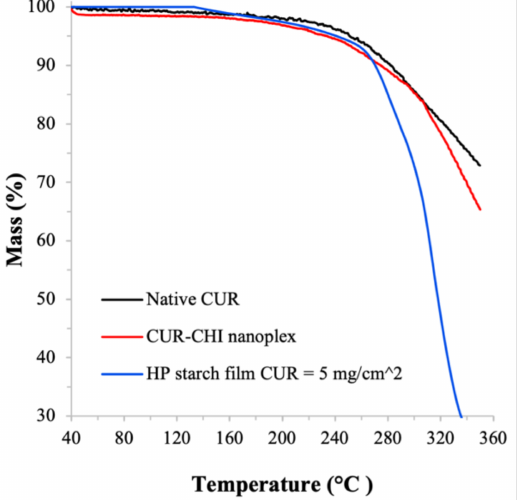
Figure A3. TGA of the HP starch film prepared at theoretical CUR payload of 5 mg/cm 2